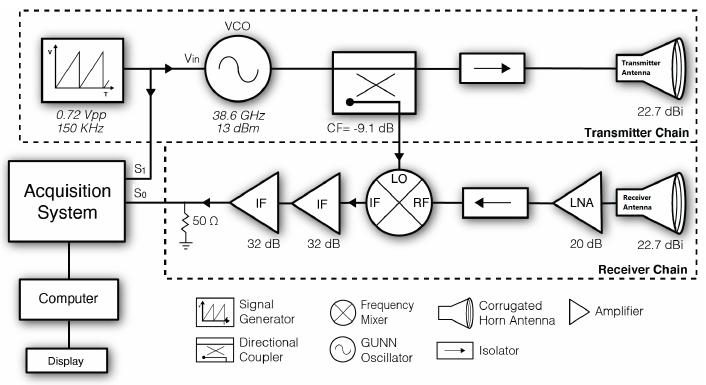
Figure 3. FMCW Radar Block